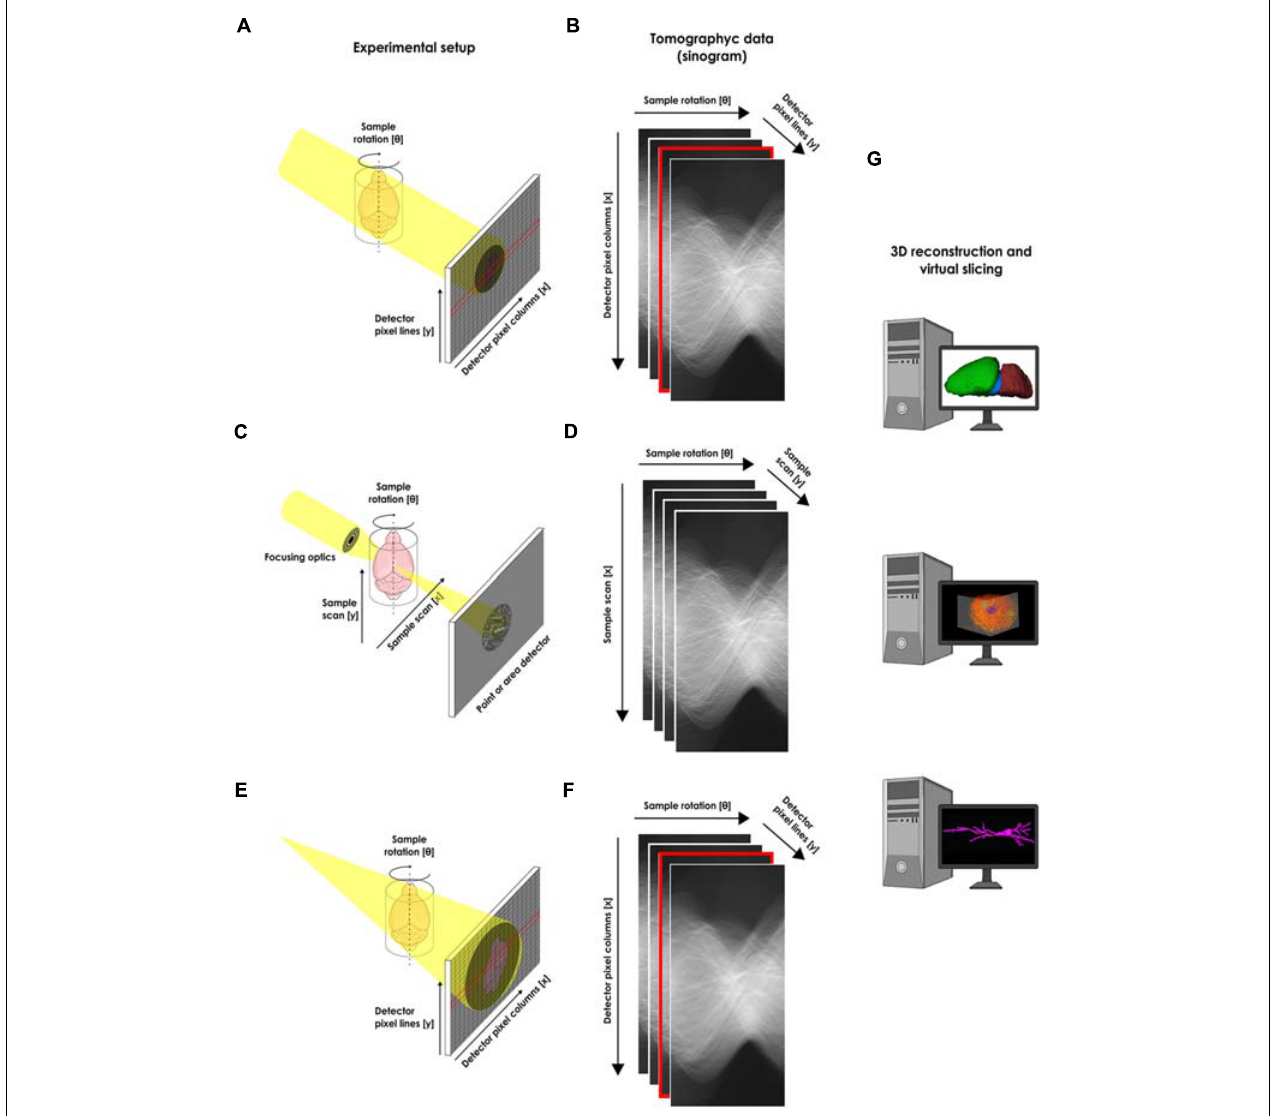
FIGURE 1 | Experimental setups for the structural x-ray microtomographic imaging of the nervous system. (A) Schematic view of the experimental setup for synchrotron-based x-ray single-frame µ CT. The x-ray from an x-ray source illuminates the whole sample and an x-ray area detector like a CCD (as portrayed), or an x-ray objective-based system (not shown) collects the transmitted projection. (B) Recorded single-frame projections organized as a sinogram. (C) Schematic view of the experimental setup for scanning synchrotron-based x-ray µ CT. The x-ray from an x-ray source is focused on a single point of the sample and a detector collects the signal from a single pixel. The beam scans the whole sample in order to compose an image. (D) Recorded scanning projections organized as a sinogram. (E) Schematic view of the experimental setup for phase-contrast synchrotron-based x-ray single-frame µ CT . (F) Recorded single-frame projections organized as a sinogram. In this case, no contrast agent is used during sample preparation and a tomogram is acquired based only on natural contrast of the tissue. An area detector is used for recording the phase shift due to abrupt change in material found on the sample edges. (G) After tomographic reconstruction, the obtained tridimensional data can be virtually segmented or sliced for analysis. Cartoons used were obtained from public domain libraries available under the Creative Commons CC0 License